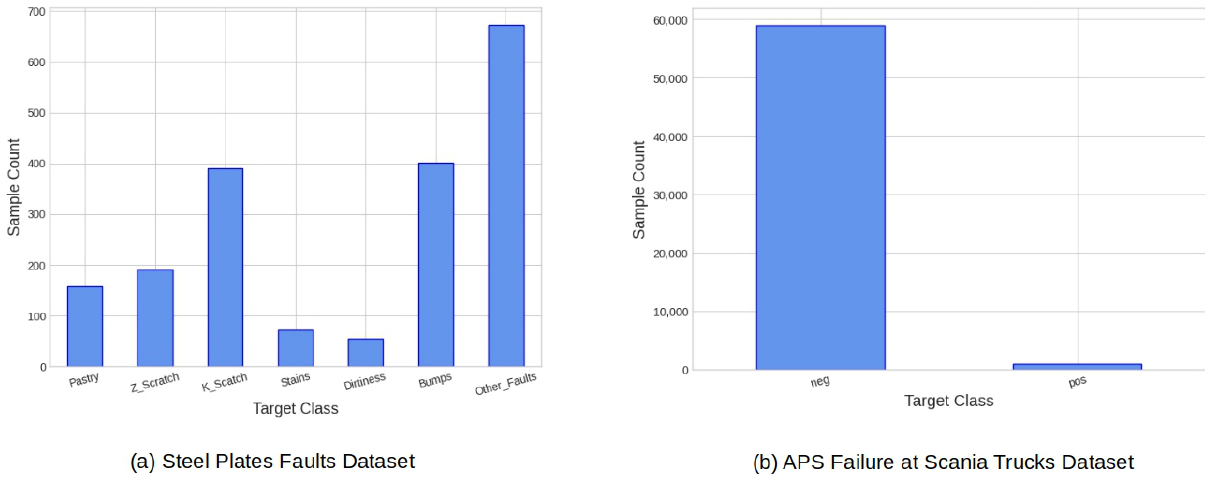
Figure 4. Plots of the datasets used in our empirical studies: ( a ) Steel Plates Faults Dataset. Classes ‘Stains’ and ‘Dirtiness’ are the minority classes. ( b ) APS Failure at Scania Trucks Dataset. Class ‘pos’ is the minority